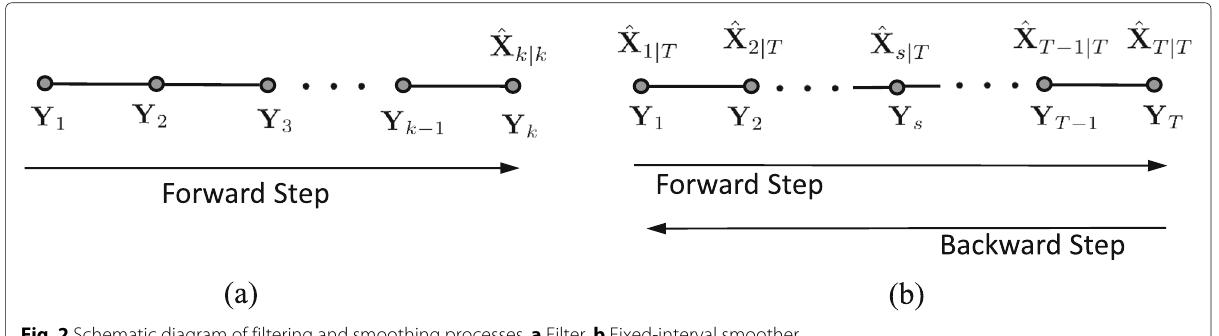
Fig. 2 Schematic diagram of filtering and smoothing processes. a Filter. b Fixed-interval